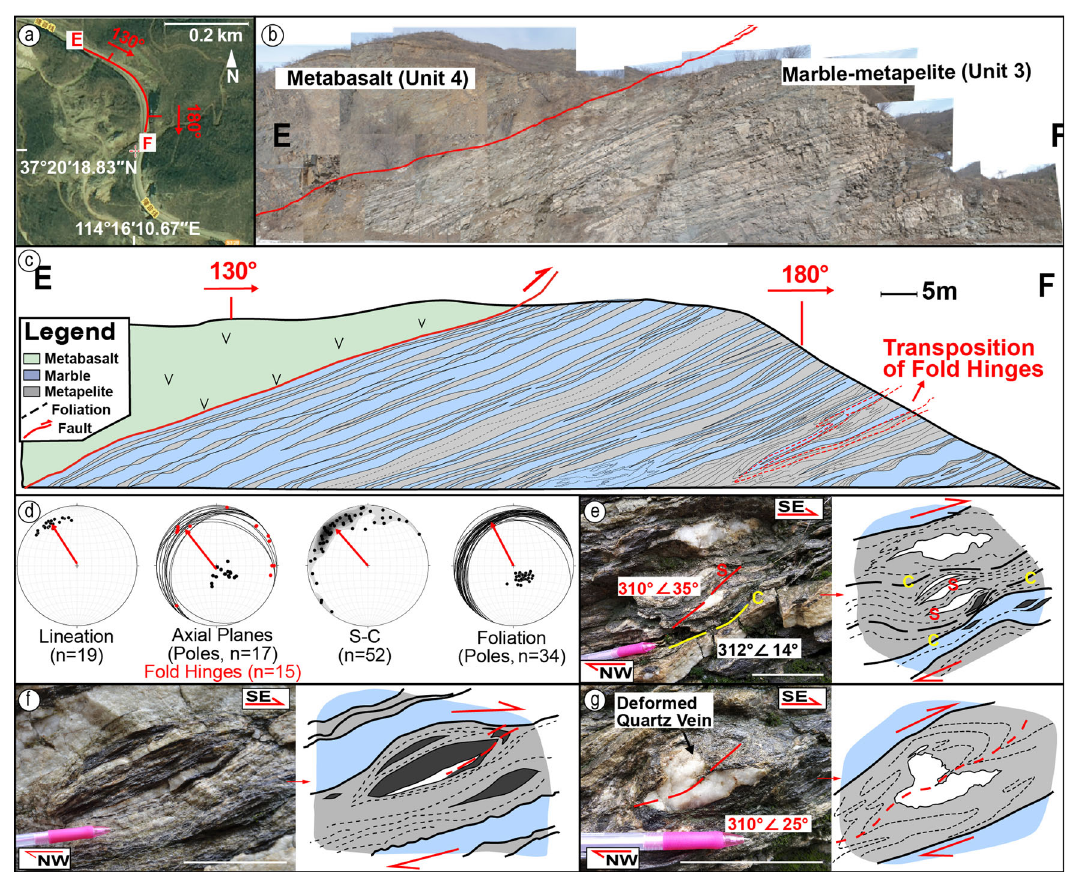
Fig. 7 | High-resolution structural pro fi le, measurements, and sketches of the marble-metapelite unit (Unit 3). a Transect satellite imagine and GPS from Map World ( 天 地 图 , www.tianditu.gov.cn), National Platform for Common Geospatial Information Service. The location is shown in Fig. 1d. b Section pictures taken by UAVdronesandmergedusingAdobePhotoshop. c Large-scale3Ddigitalstructural